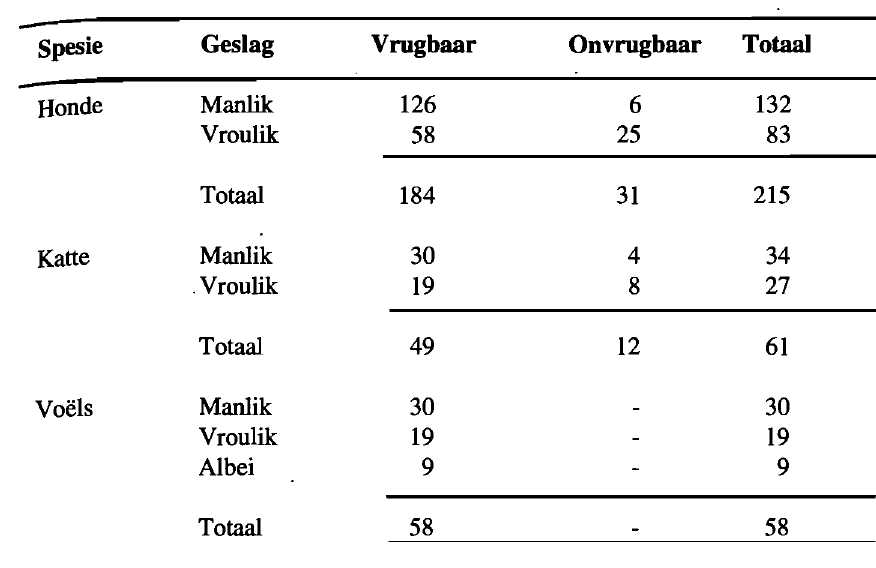
Tabe12: Geslag en vrugbaarheid van diere soos gereflekteer in radioprogram-